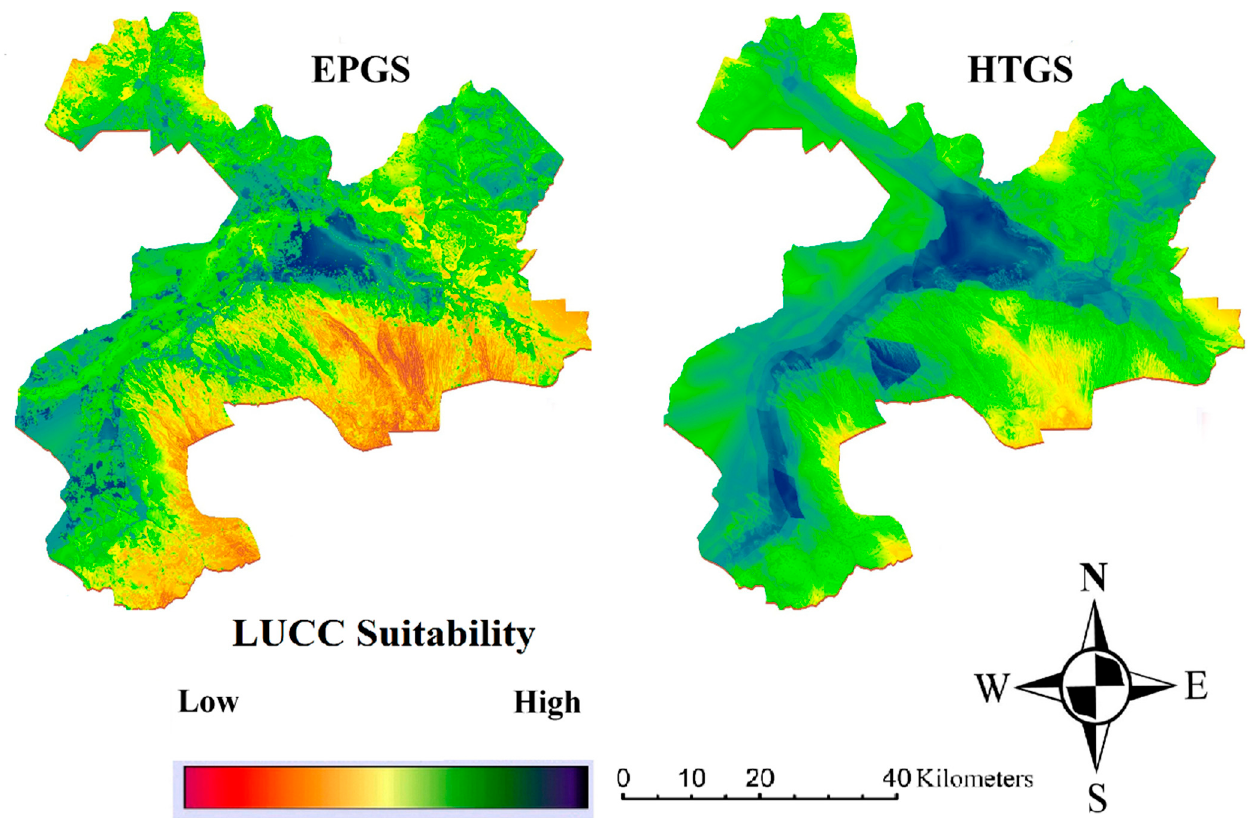
Figure 9. Layer of LUCC potential in scenarios.